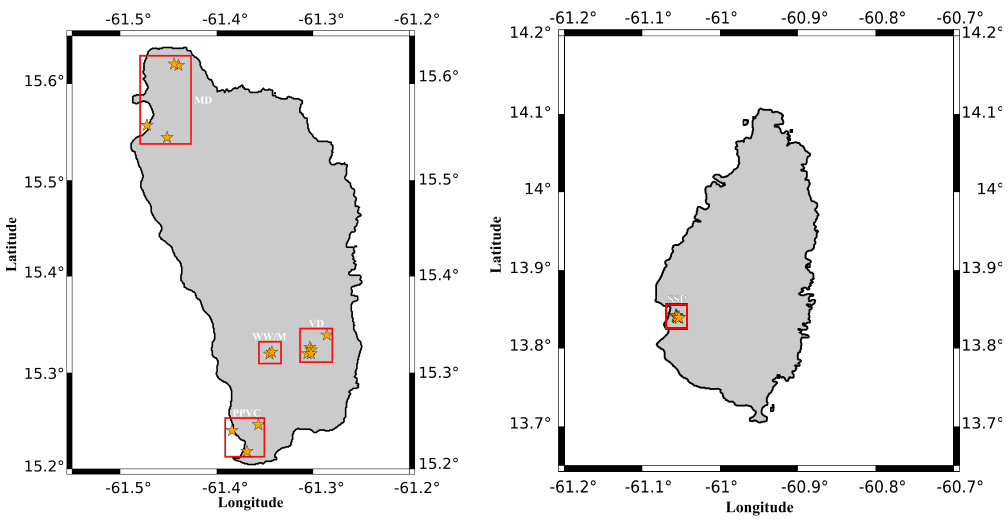
Figure 13. ( Left ) Dominica geothermal sites monitored by SRC as of 2000. ( Right ) Geothermal sites monitored by SRC at Sulphur Spring Park in the Soufrière Volcanic Centre, Saint Lucia. MD: Morne aux Diables; WW/M: Wotten Waven/ Morne Micotrin; VD: Valley of Desolation; PPVC: Plat Pays Volcanic Complex; SSP: Sulphur Spring Park of the Soufrière Volcanic Complex. Map reproduced using site location retrieved after